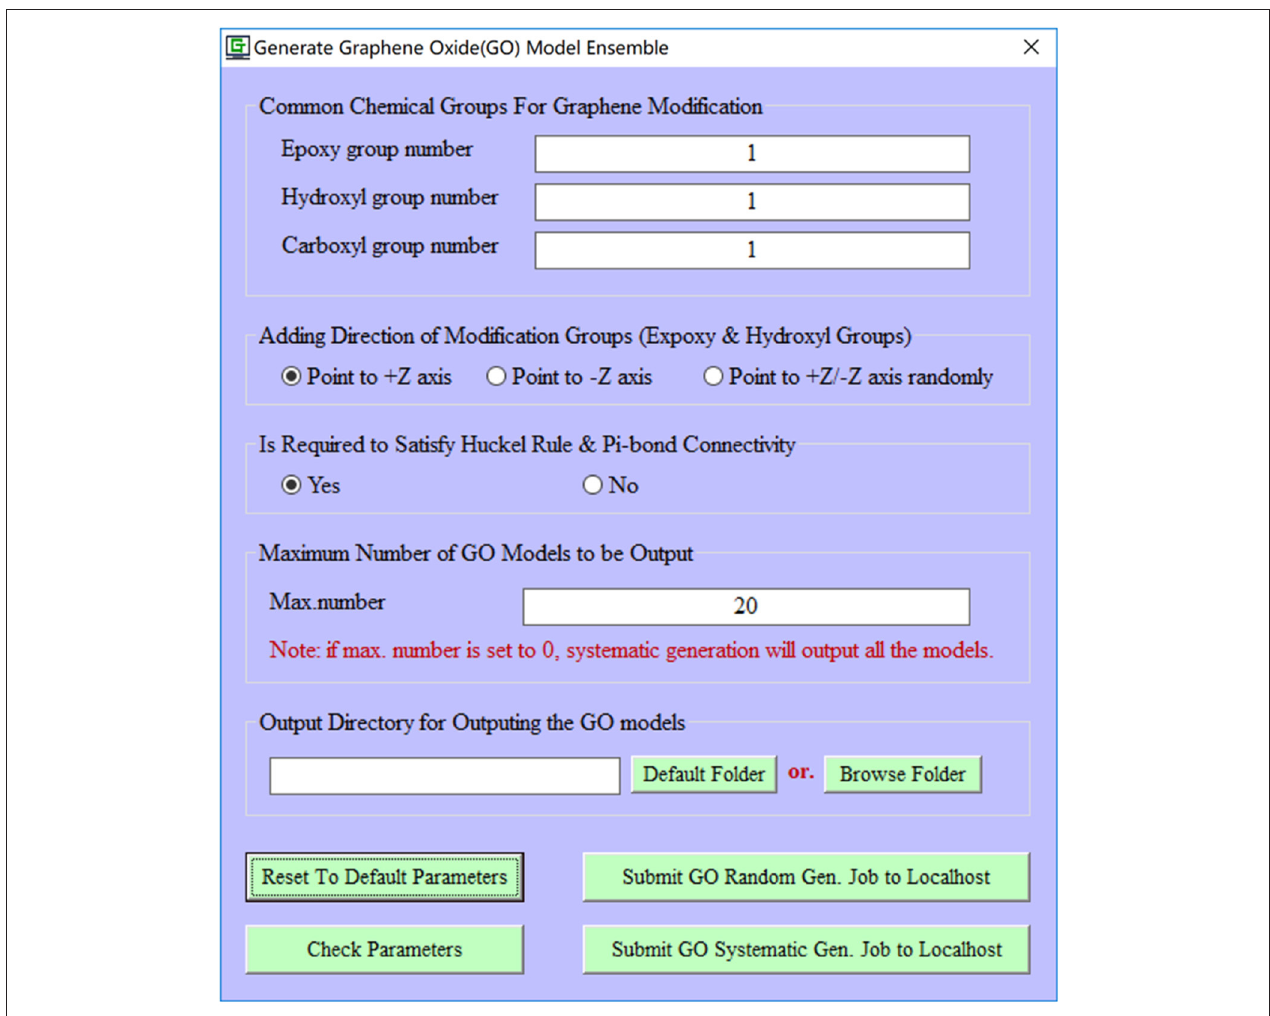
FIGURE 2 | Automatic generation of an ensemble of graphene oxide (GO) models for a given pristine graphene